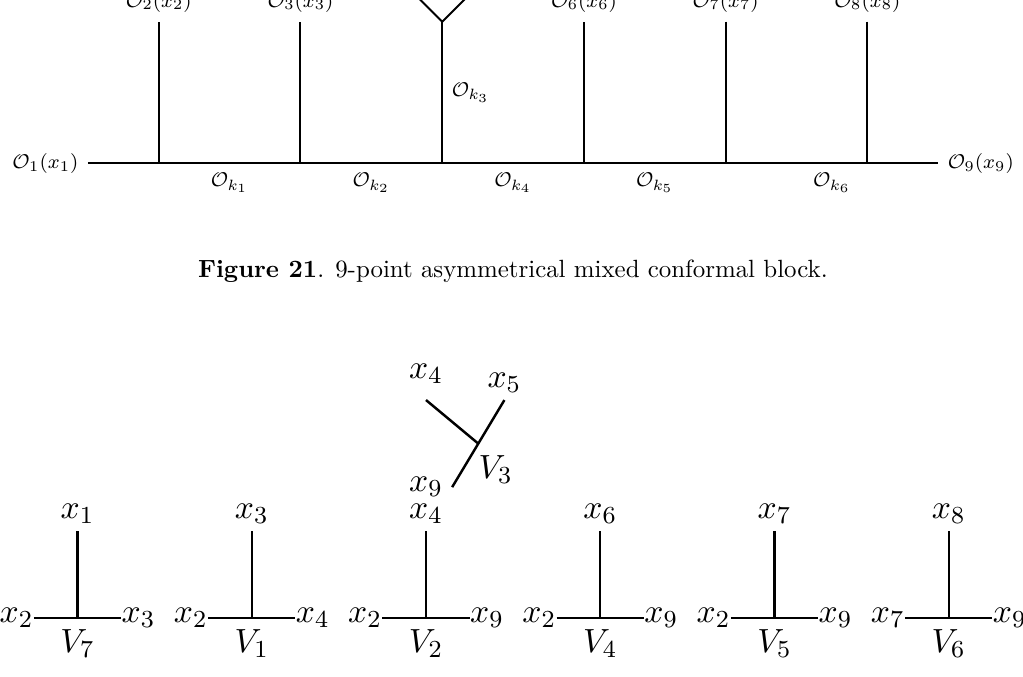
Figure 22 . Flow diagram using rules in section 2 for the 9-point asymmetrical